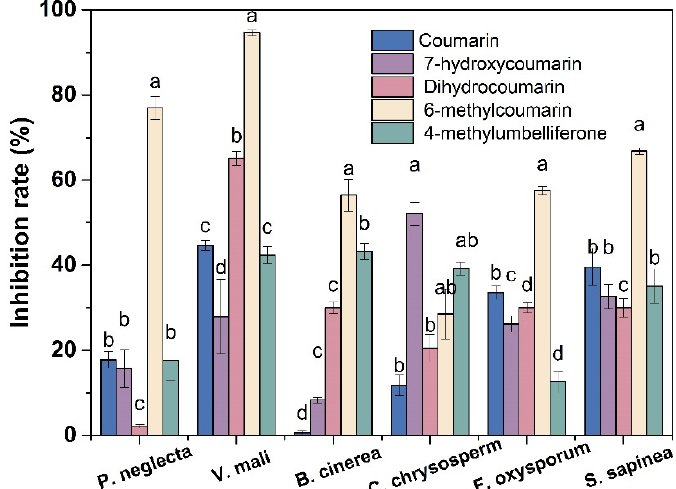
Figure 2. Inhibitory effects of five coumarin compounds on mycelial growth of six phytopathogenic fungi. The bars represent the standard error of the mean (n = 3), and letters (a–d) represent the difference between the inhibitory effects of the five coumarin compounds.